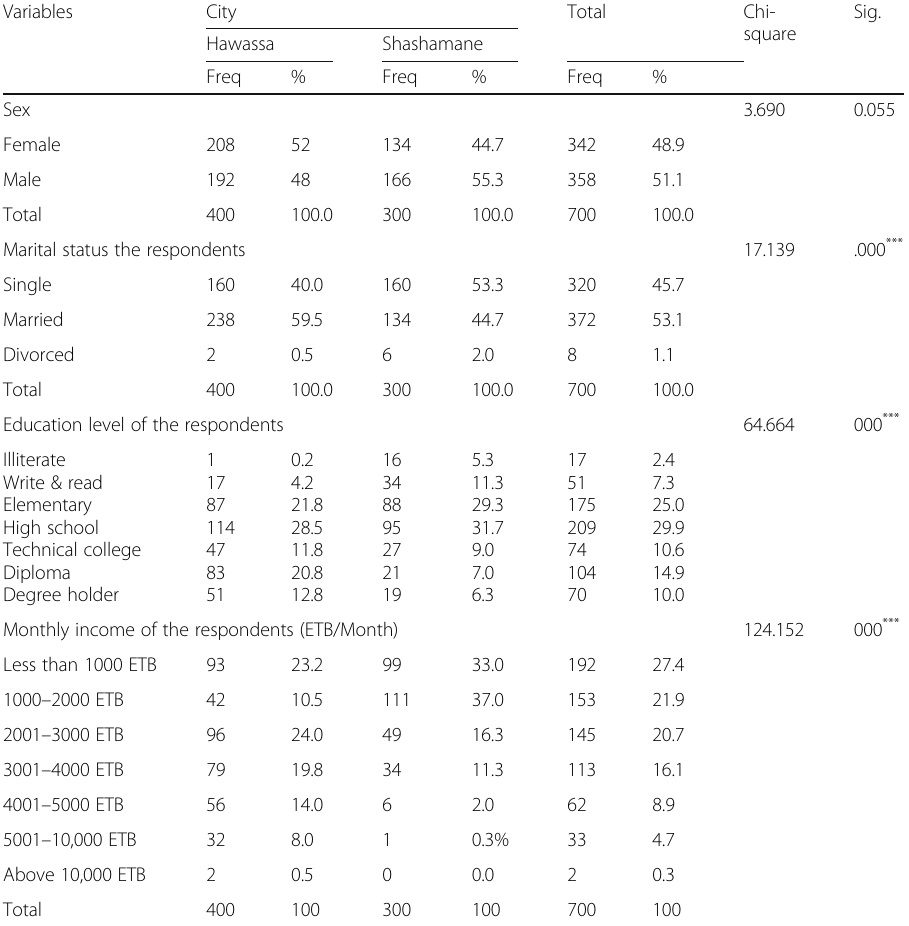
Table 4 Sample respondents ’ sex, marital status, educational level, and monthly income